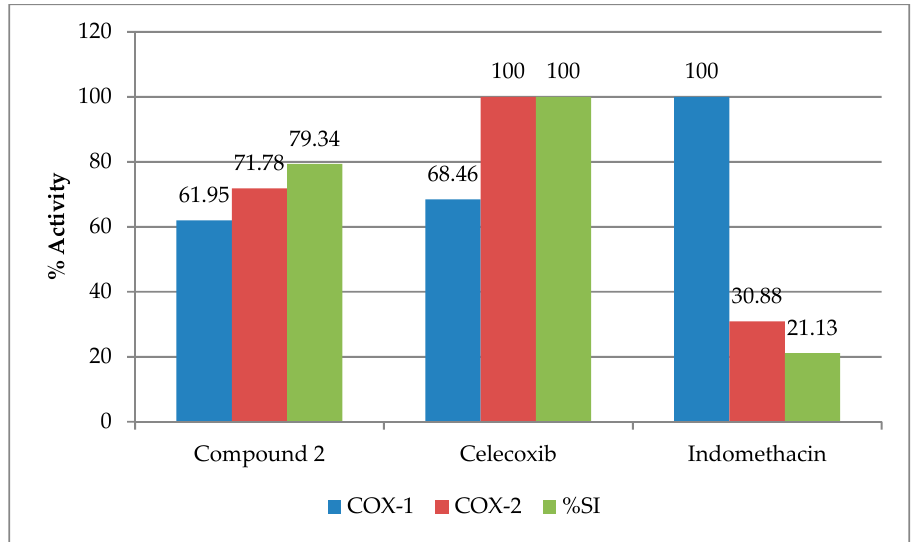
Figure 6. The %COX-1/COX-2 inhibition and %SI of compound 2 , celecoxib and indomethacin .